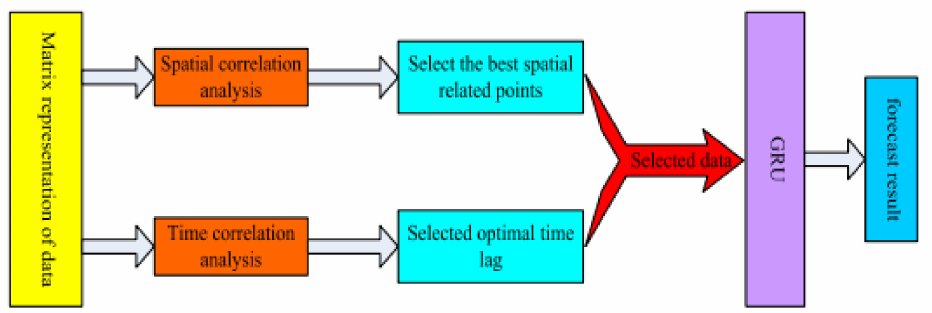
Figure 28. GRU framework for traffic prediction